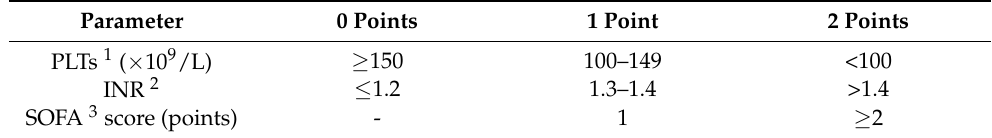
Table 1. International Society on Thrombosis and Hemostasis sepsis-induced coagulopathy diagnostic scoring system. Based on